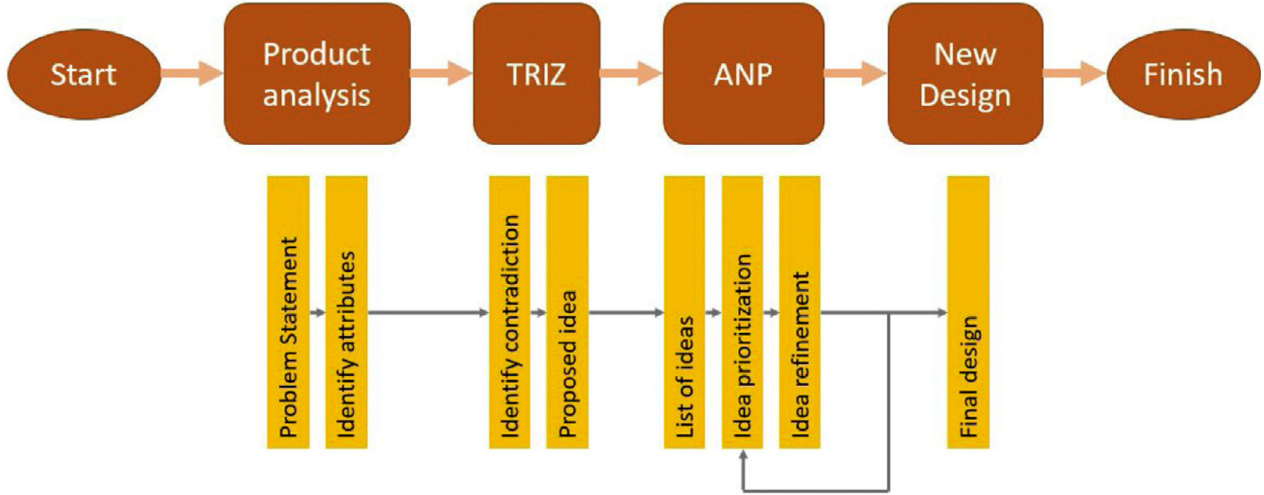
Figure 4. The application of TRIZ in the concurrent engineering conceptual design framework to develop the product [100].